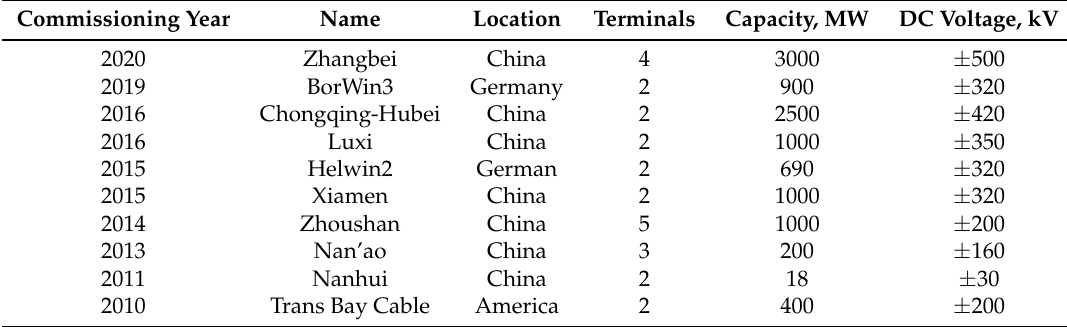
Table 1. Modular multilevel converter-high voltage direct current (MMC-HVDC) projects in operation or under construction world wide.